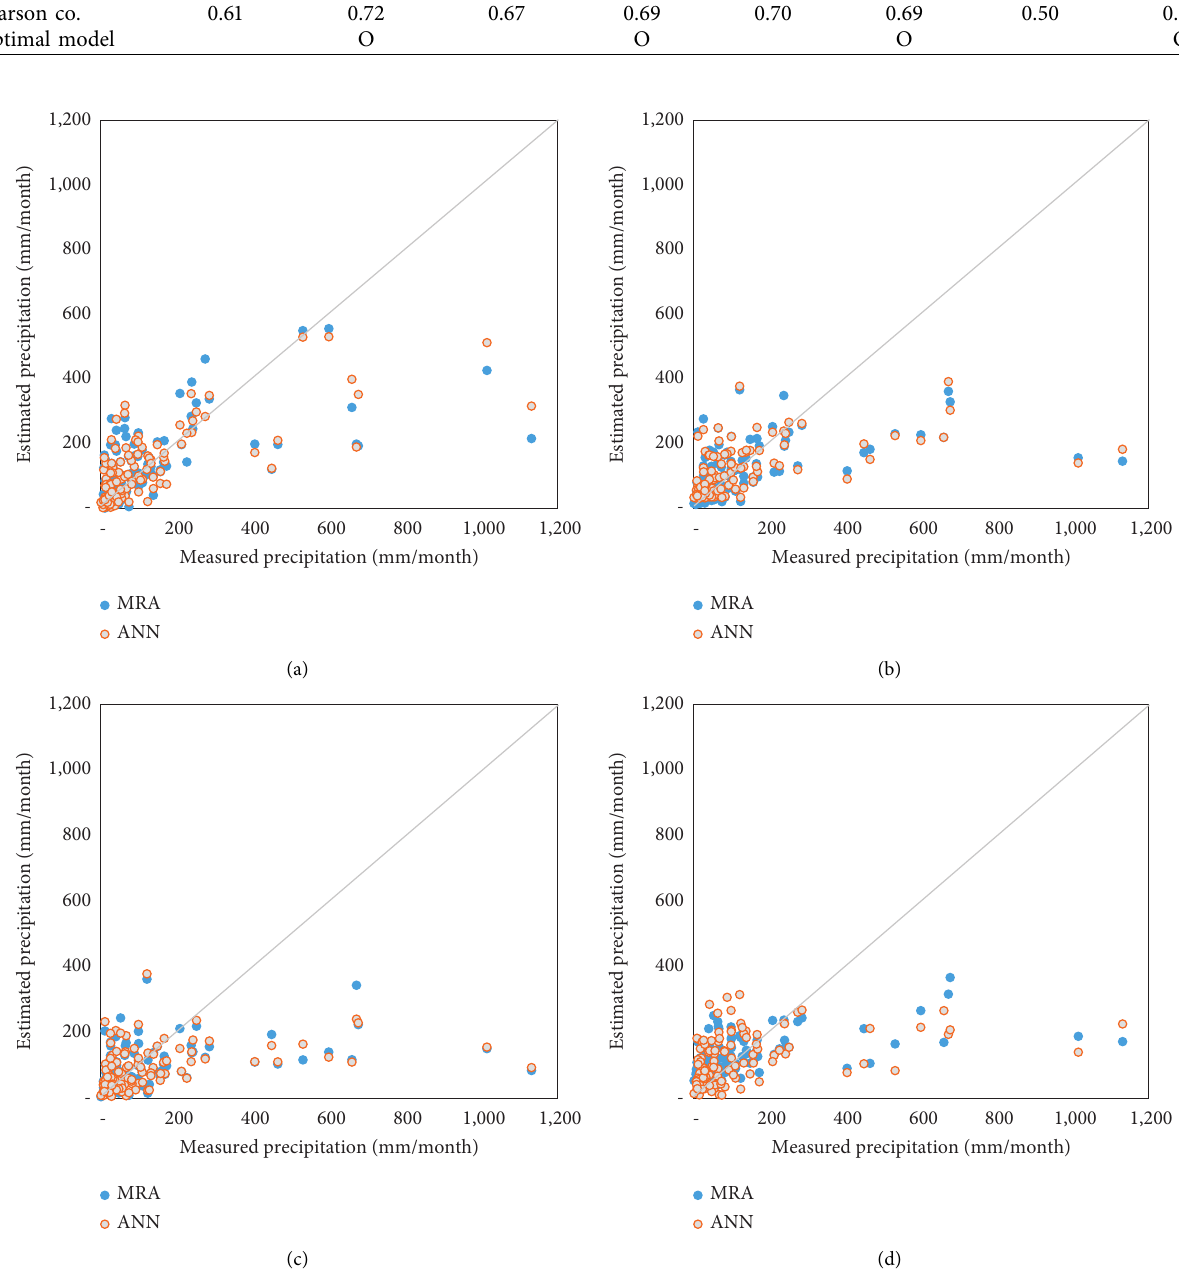
Figure 6: Precipitation comparison between ANN and MRA with observed value: (a) Seoul, (b) Daejeon, (c) Daegu, and (d)